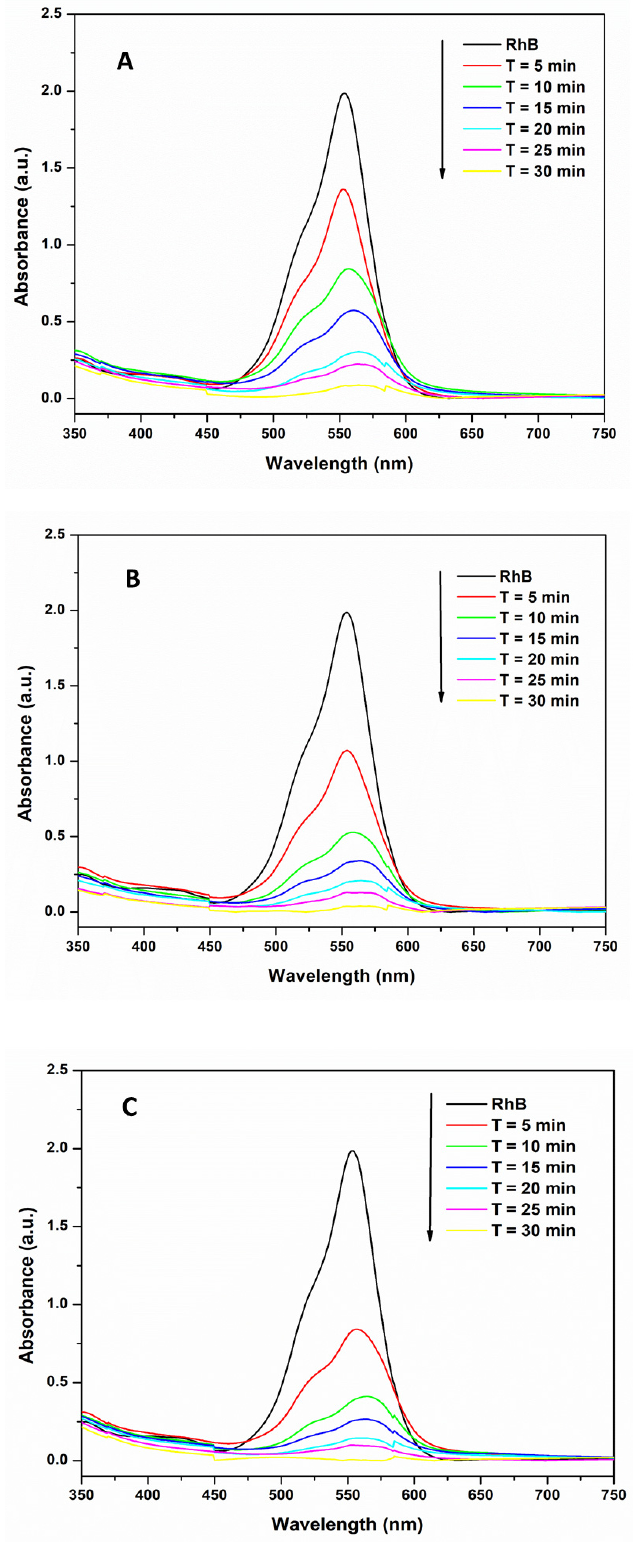
Figure 7. UV–Vis spectrum of RhB solution subjected to decolorization of RhB (20 mg L − 1 ) with unmodified graphite ( A ); BVO@C EC System ( B ); and BVO@C PEC System ( C ) at different reaction times using NaCl as electrolytic support (0.05 mol L − 1 ).